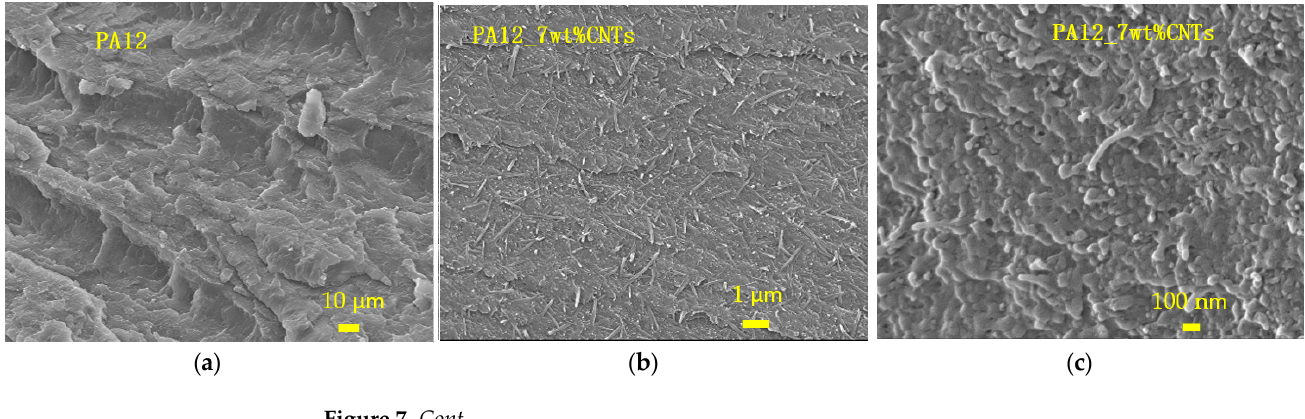
Figure 6. The fabricated coupons of PA12 and PA12 with 10% and 20% inclusions of CNTs@chopped CFs.